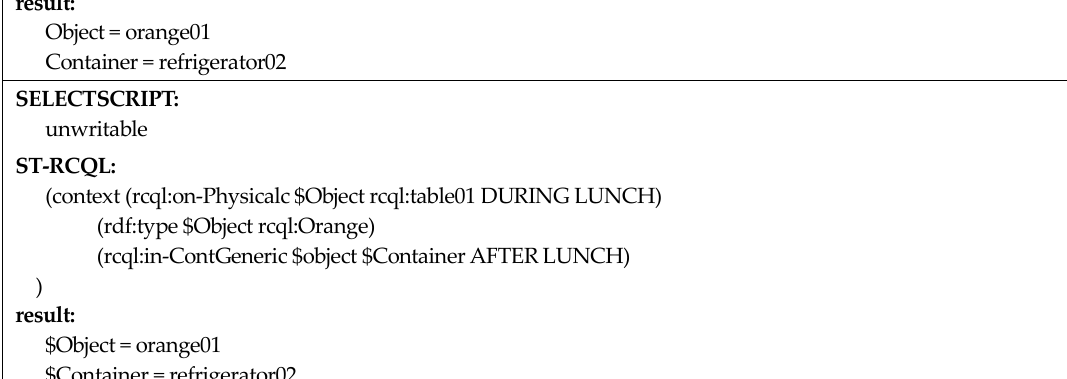
Figure 18. Comparison of spatio-temporal context queries three.